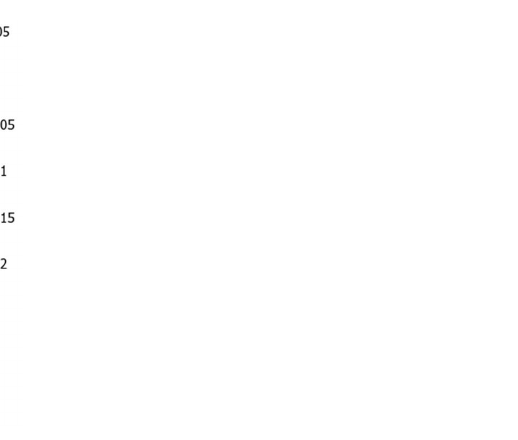
Figure 7. Classification accuracy (F1-score) losses in target systems compared to reference system accuracies for all six experiments based on three sensor inputs and two feature selection approaches. The abbreviation keys are provided in Table 2.